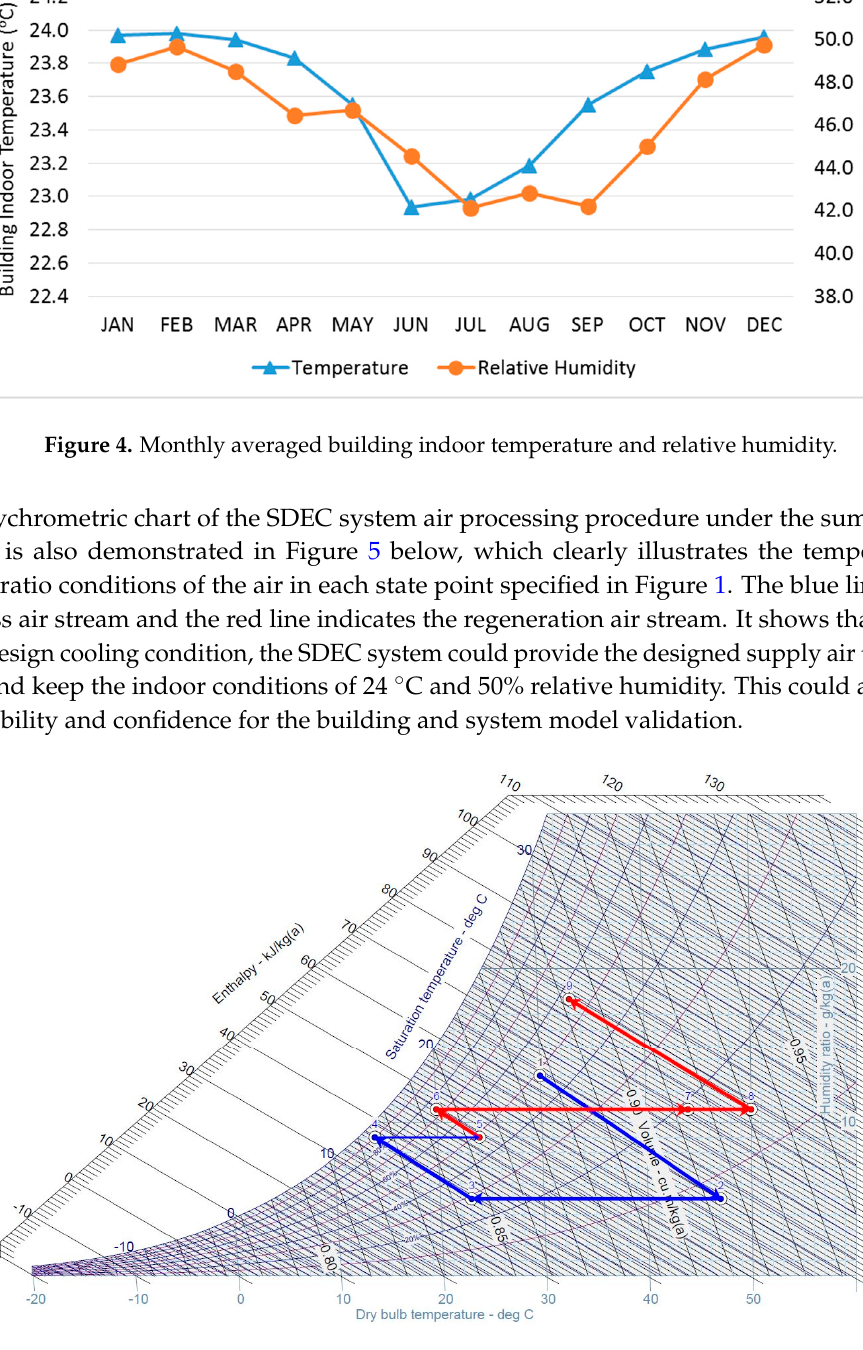
Figure 3. Monthly building cooling and heating load.